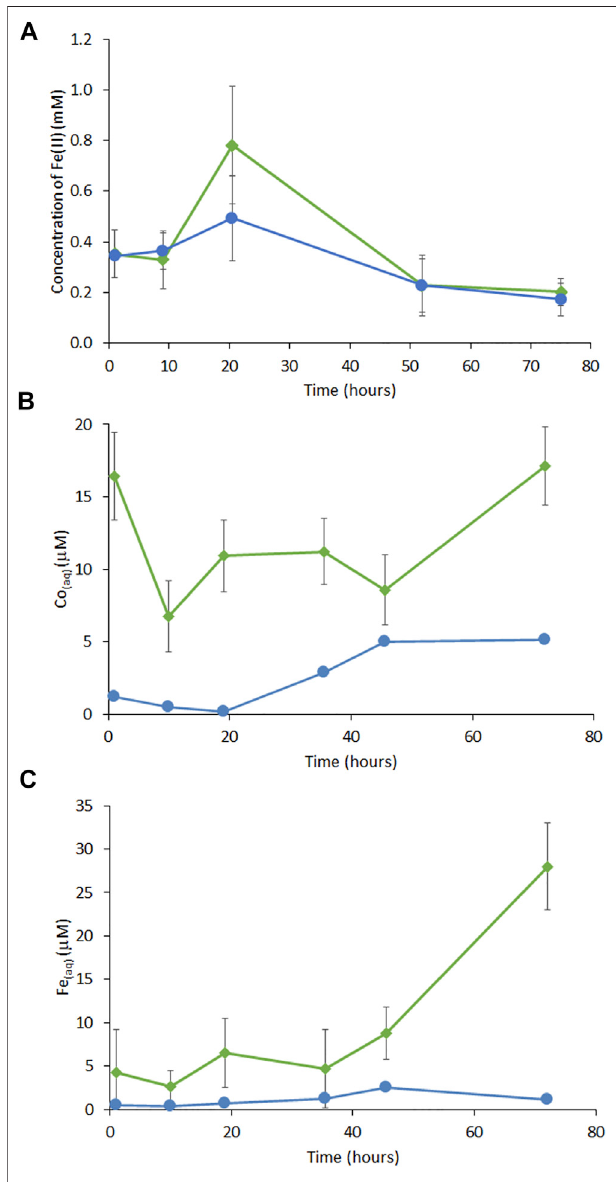
FIGURE 1 | (A) Concentration of Fe(II) from measurement of 0.5 M HCl digestion of slurry by ferrozine assay, (B) ICP-MS monitoring of aqueous phase Coand (C) ICP-AESmonitoring ofaqueousFeinCo-dopedferrihydrite with G. sulfurreducens (green lines) and no electron donor controls (blue lines). Error bars are ±1 standard